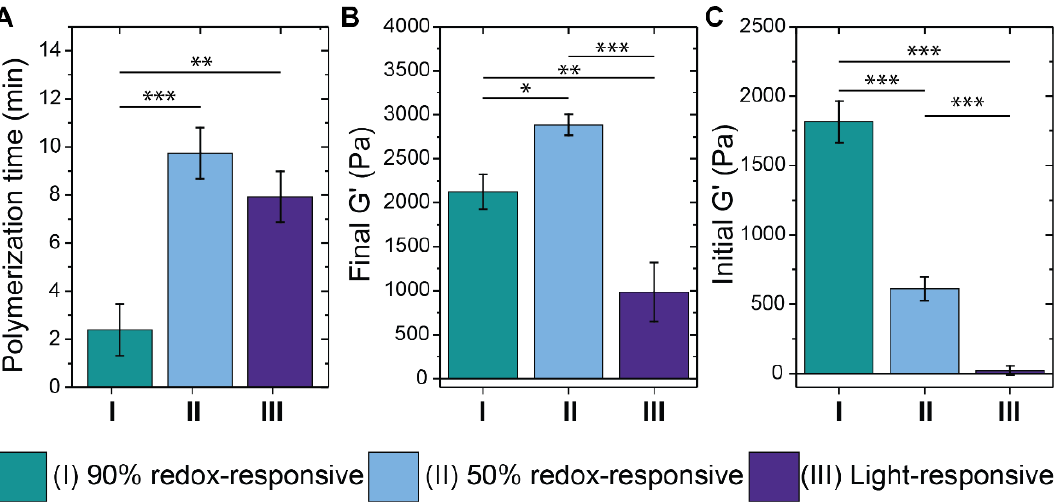
Figure 2. Mechanical properties of hydrogel formulations. The polymerization time ( A ), the final in situ storage modulus ( B ), and the initial in situ storage modulus value recorded by the rheometer ( C ) were examined for each hydrogel formulation. The final formulations investigated were (I) 90% and (II) 50% redox-sensitive crosslinked and (III) NB light-responsive SPAAC crosslinked hydrogels. Shown is the average and standard error for n = 3 samples, where * indicates p < 0.05; ** indicates p < 0.01; *** indicates p < 0.001.